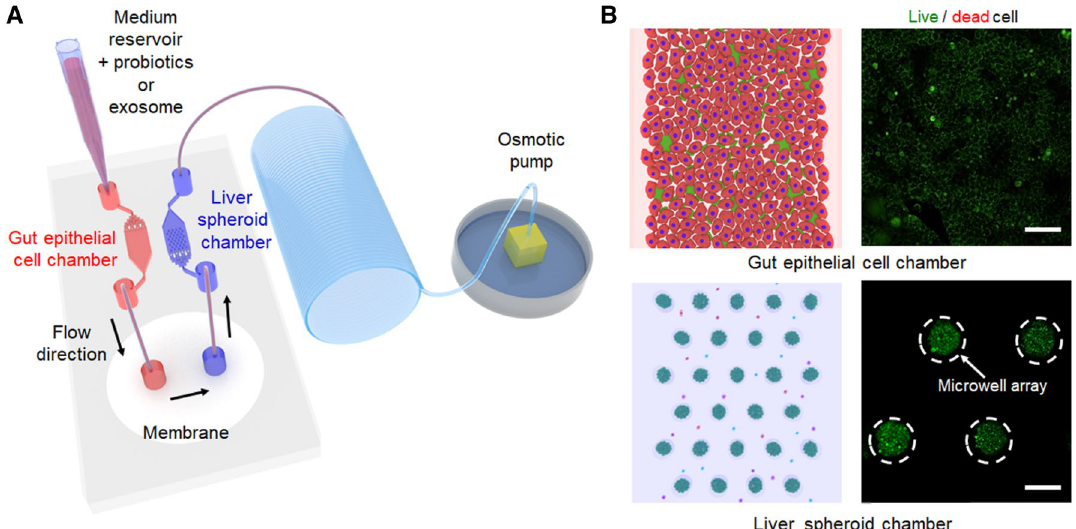
Fig. 1 A The schematic of experimental setup of a gut‑liver axis chip. The left chamber was used to establish an intestinal lumen using human epithelial Caco‑2 cells. The right chamber, which contains microwell arrays, was employed to generate the 3D uniform‑sized hepG2 spheroids. The continuous flow of the culture medium was introduced by an osmotic pump. B Schematic images of gut and liver spheroid chamber as well as representative immunofluorescence results showing that microbial and 3D hepG2 spheroids were located in the left gut chamber and right liver